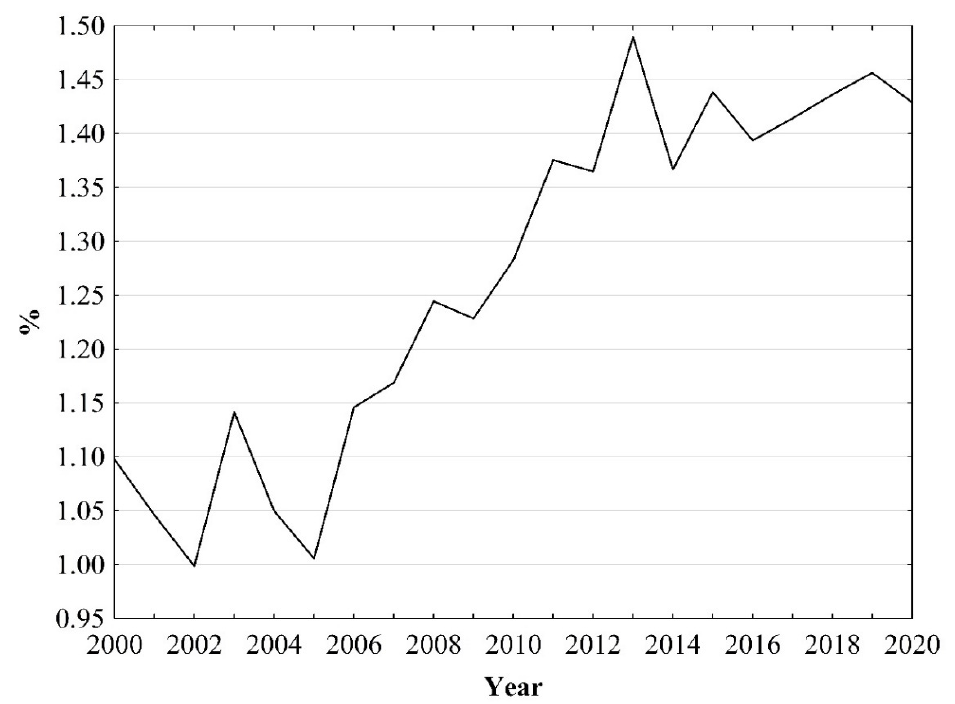
Figure 1. Percentage of deaths due to skin melanoma in comparison to deaths due to malignant neoplasms in Poland in 2000–2020. Source: own calculations.